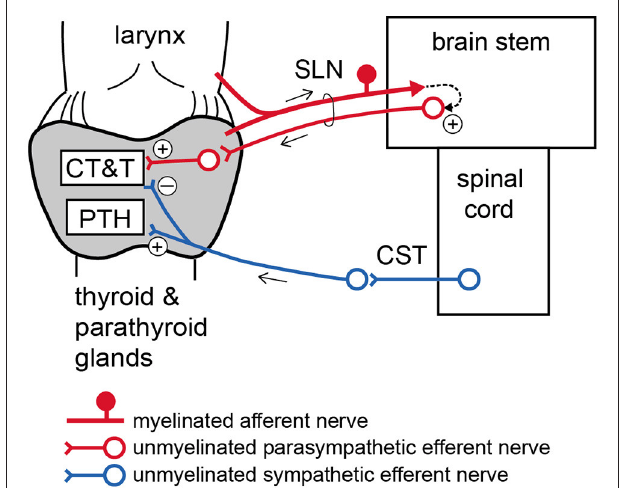
FIGURE 6 | Schematic diagram of proposed autonomic nervous regulation of the thyroid and parathyroid glands. CT, calcitonin; T, thyroid hormone; PTH, parathyroid